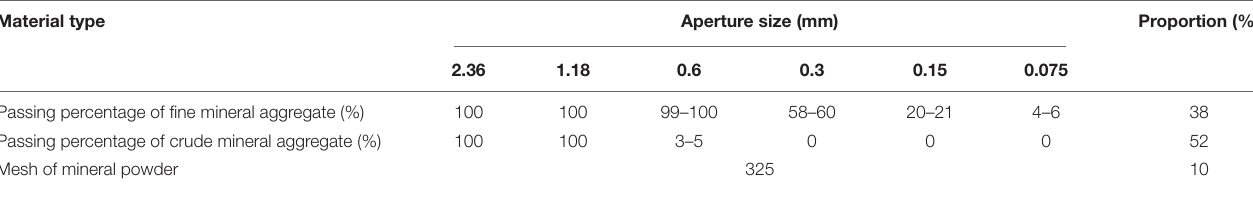
TABLE 4 | Percent of each component of the mineral aggregate passing through screen aperture and the proportion of each blending. Material